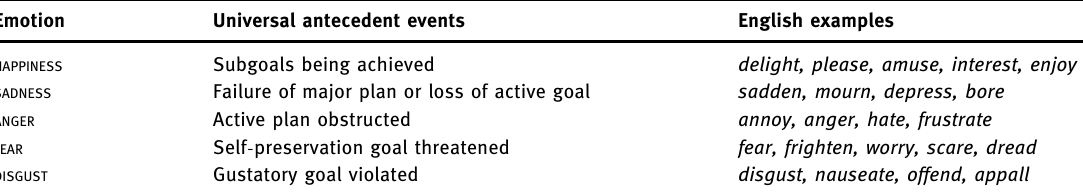
Table 1: Basic emotion modes and universal antecedent events Emotion Universal antecedent events English